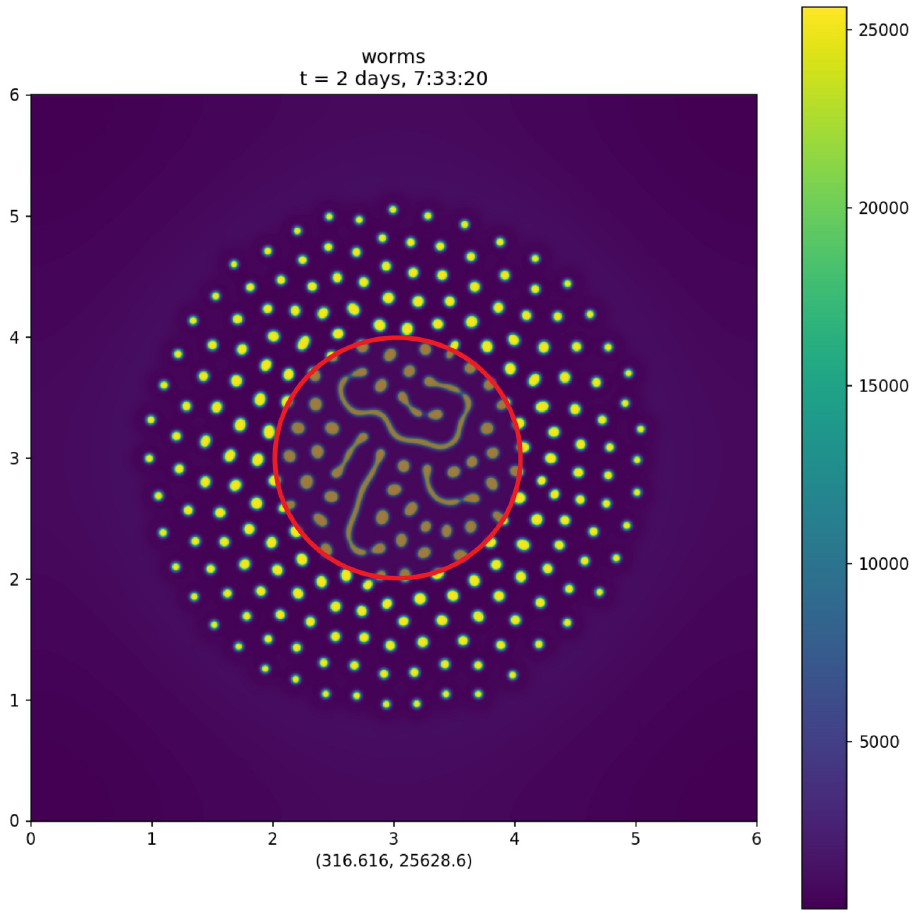
Fig 6. Full-scale attractant+repellent simulation. Simulation of the attractant+repellent model on a 6 × 6 cm domain. The simulation began with 68 400 worms in a 2 cm diameter circle at the center of the plate (inner red circle). (S6 Video shows the entire time course.) The spatial units are centimeters. The two numbers below the plot are the minimum and maximum values of the plotted function over the entire 6 cm × 6 cm domain. Density is muted in a central 2 cm diameter circle, corresponding to where the worms were initially placed, to suggest the region in which we think influences not included in our model might be